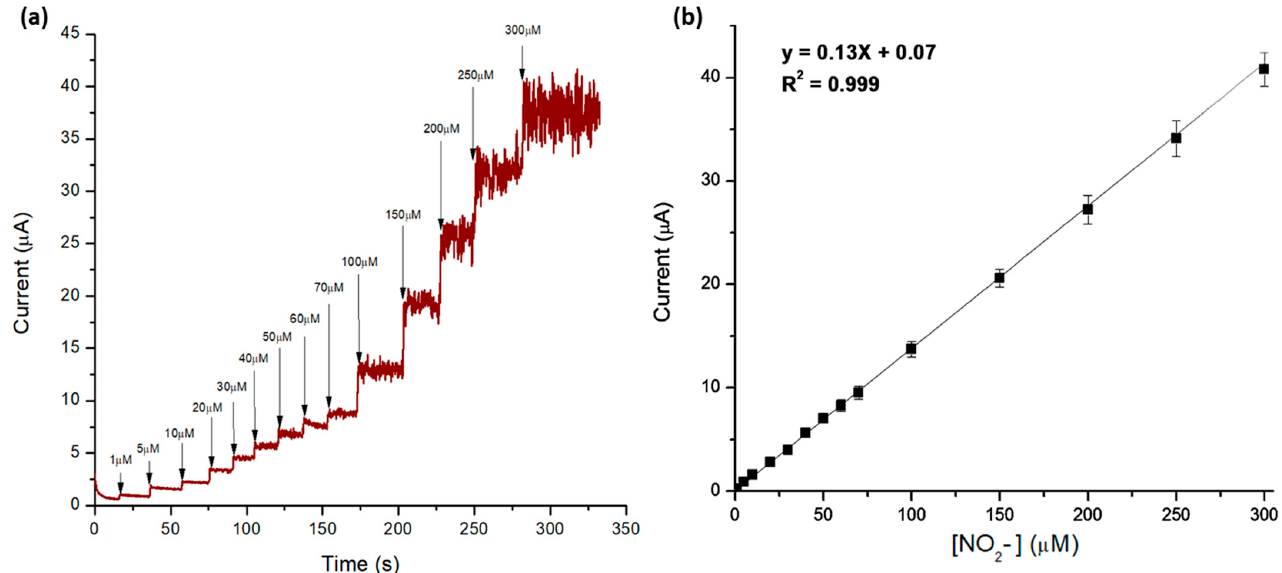
Figure 3. ( a ) Chronoamperometric ( i–t ) response of a HMT-PMBI/NGNP coated electrode obtained with the successive addition of nitrite from 1 µM to 300 µM. The supporting electrolyte was 0.1 M NaCl (pH 7) and applied potential was 0.86 V. ( b ) Calibration plot of the chronoamperometric ( i–t ) current vs. the nitrite